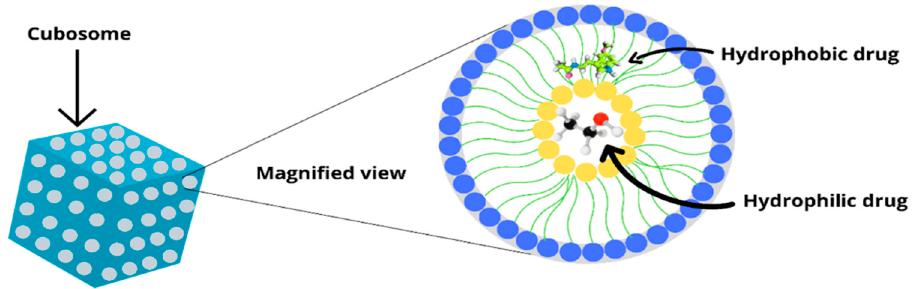
Figure 1. Structure of a cubosome.